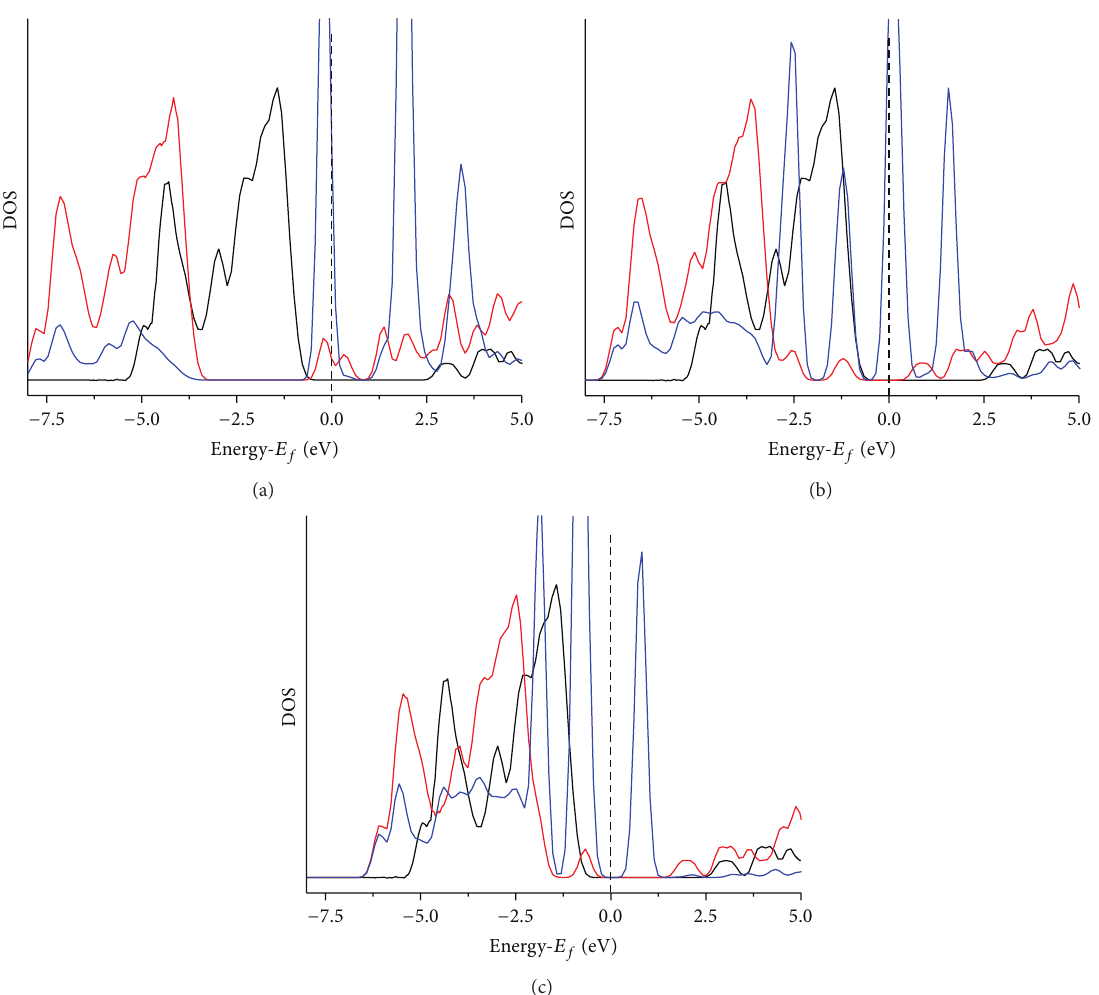
Figure 4: DOS of the V (a), Fe (b), and Ni (c) doped MgO(100) surfaces. In all cases, undoped, doped, and projected DOS of the doping atom are displayed with black, red, and blue lines, respectively. Only region near to the Fermi level is plotted for a better